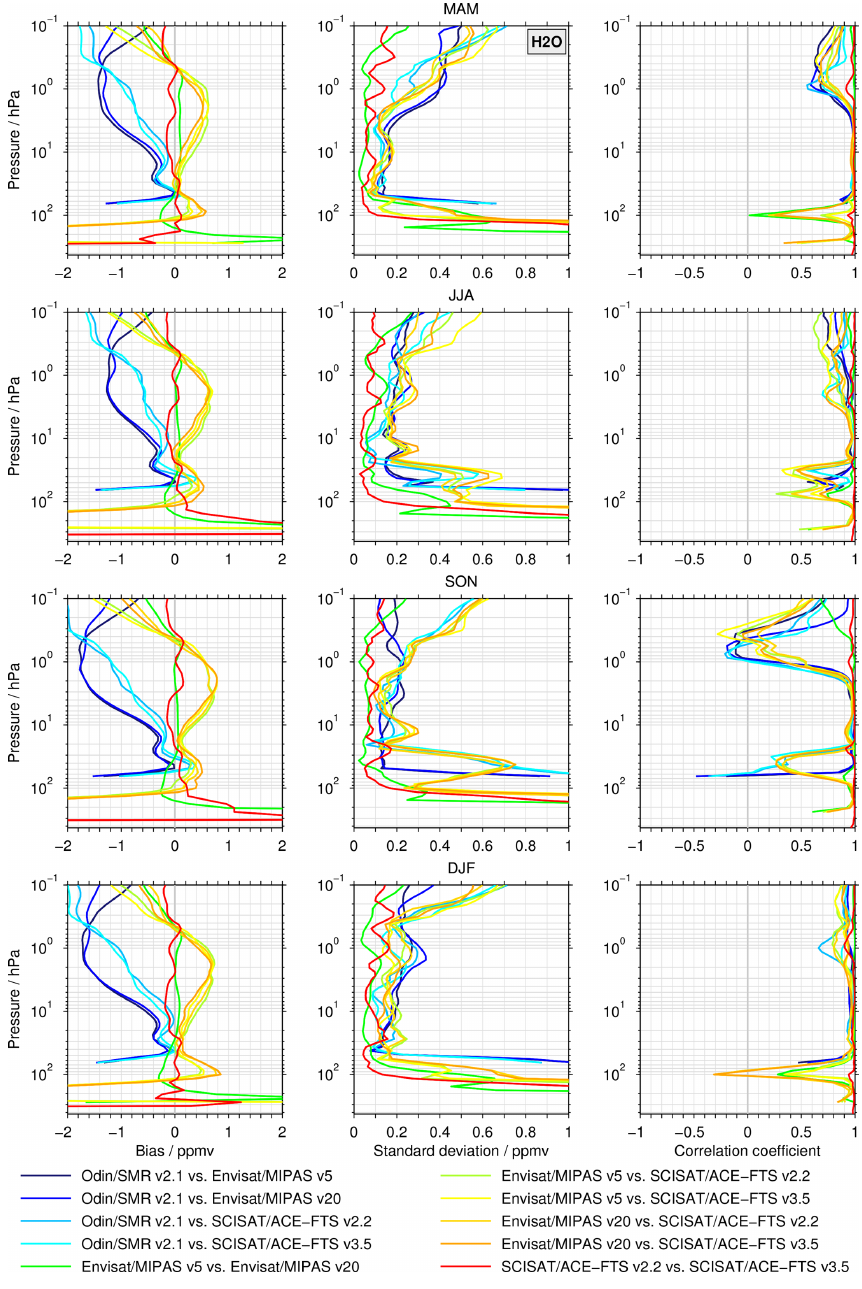
Figure 9. As for Figs. 7 and 8 but for H 2 O.